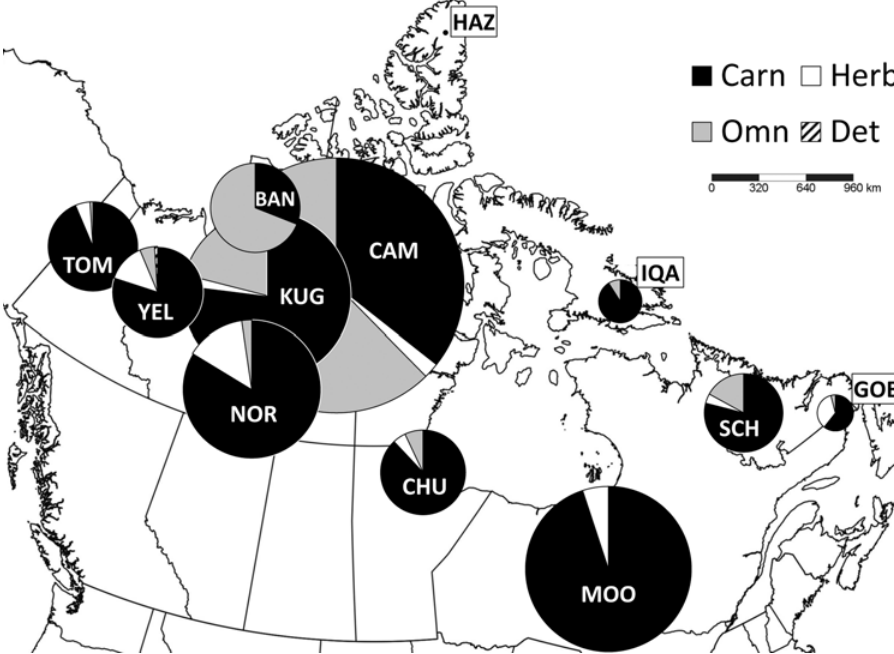
Fig 1. Map of the 12 study locations (North Pole Azimuthal projection), showing the spatial distribution of functional groups. FGs were pooled into trophic groups, and the pie charts show the proportion of the total site biomass represented by each trophic group: carnivore (black), herbivore (white), omnivore (grey) and detritivore (diagonal lines). Pie chart sizes are graduated according to the proportion of the entire study ’ s beetles collected at that site. High arctic sites: HAZ (Lake Hazen, NU); BAN (Banks Island, NWT); CAM (Cambridge Bay, NU); IQA (Iqaluit, NU). Subarctic sites: KUG (Kugluktuk, NU); TOM (Tombstone Mtns., YT); CHU (Churchill, MB); SCH (Schefferville, QC). North boreal sites: NOR (Norman Wells, NWT); YEL (Yellowknife, NWT); GOB (Goose Bay, NFLD); MOO (Moosonee,